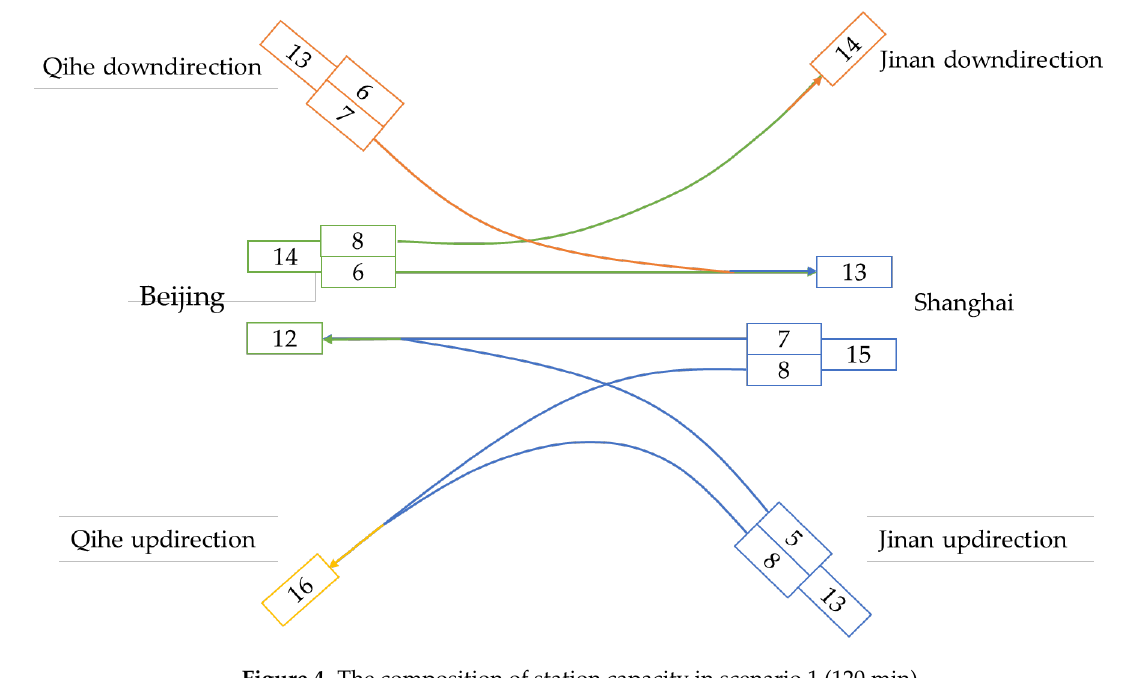
Figure 4. The composition of station capacity in scenario 1 (120 min).